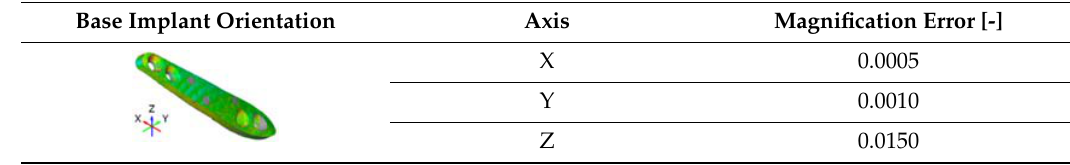
Table 8. The magnification error of the additively manufactured end-use implant with reference to the nominal CAD implant.